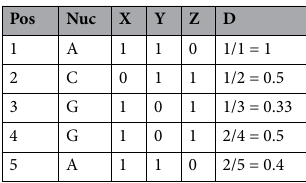
Table 2. Four property representation scheme detail of “ACGGA”